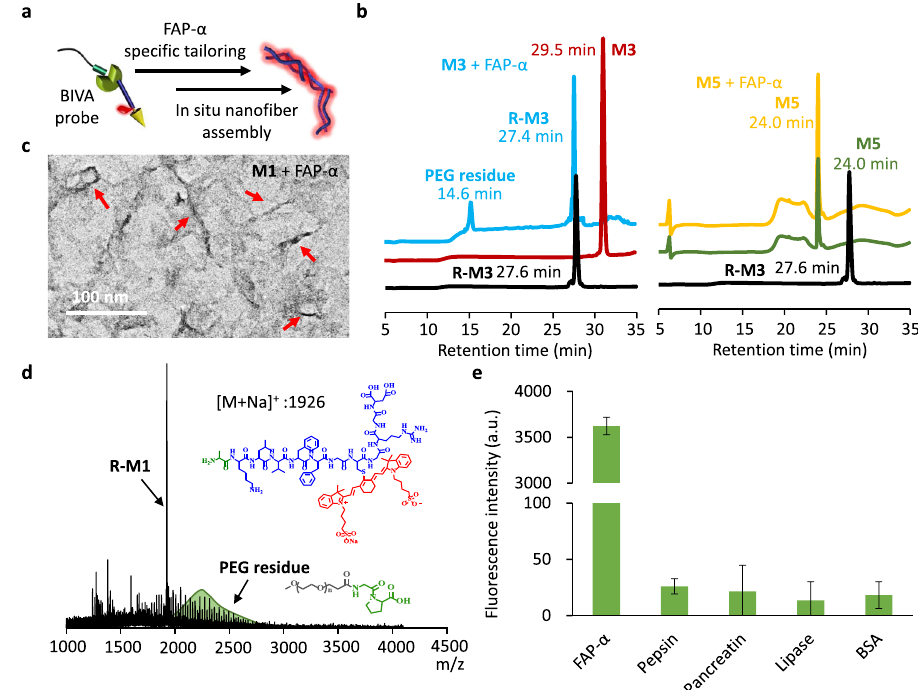
Fig. 4 The FAP- α speci fi c molecule tailoring and inducing in situ assembly. a The illustration the working mechanism of BIVA probe based on FAP- α catalytic hydrolysis. b HPLC curves of M3 and M5 after incubation with FAP- α in buffer. R-M3 , M3 and M5 were synthesized controls. The TEM image ( c ), and the MALDI-TOF ( d ), results of M1 after tailoring by FAP- α in buffer, the red arrows represent the assembled fi brils of M1 after incubation with FAP- α . e The enzyme speci fi city of M1 in buffer. Buffer: 50 mM Tris, 1 M NaCl, 1 mg/mL, BSA, pH 7.5; Concentration of M1 and M3 : 100 μ M; Concentration of FAP- α : 50 μ M; incubation time: 12 h. The mean of data of four samples with the same conditions is shown and data are presented as mean values± SD ( n = 4). p = 2.04E-22< 0.001, p values were performed with one-way ANOVA by post hoc Tukey ’ s test for the indicated